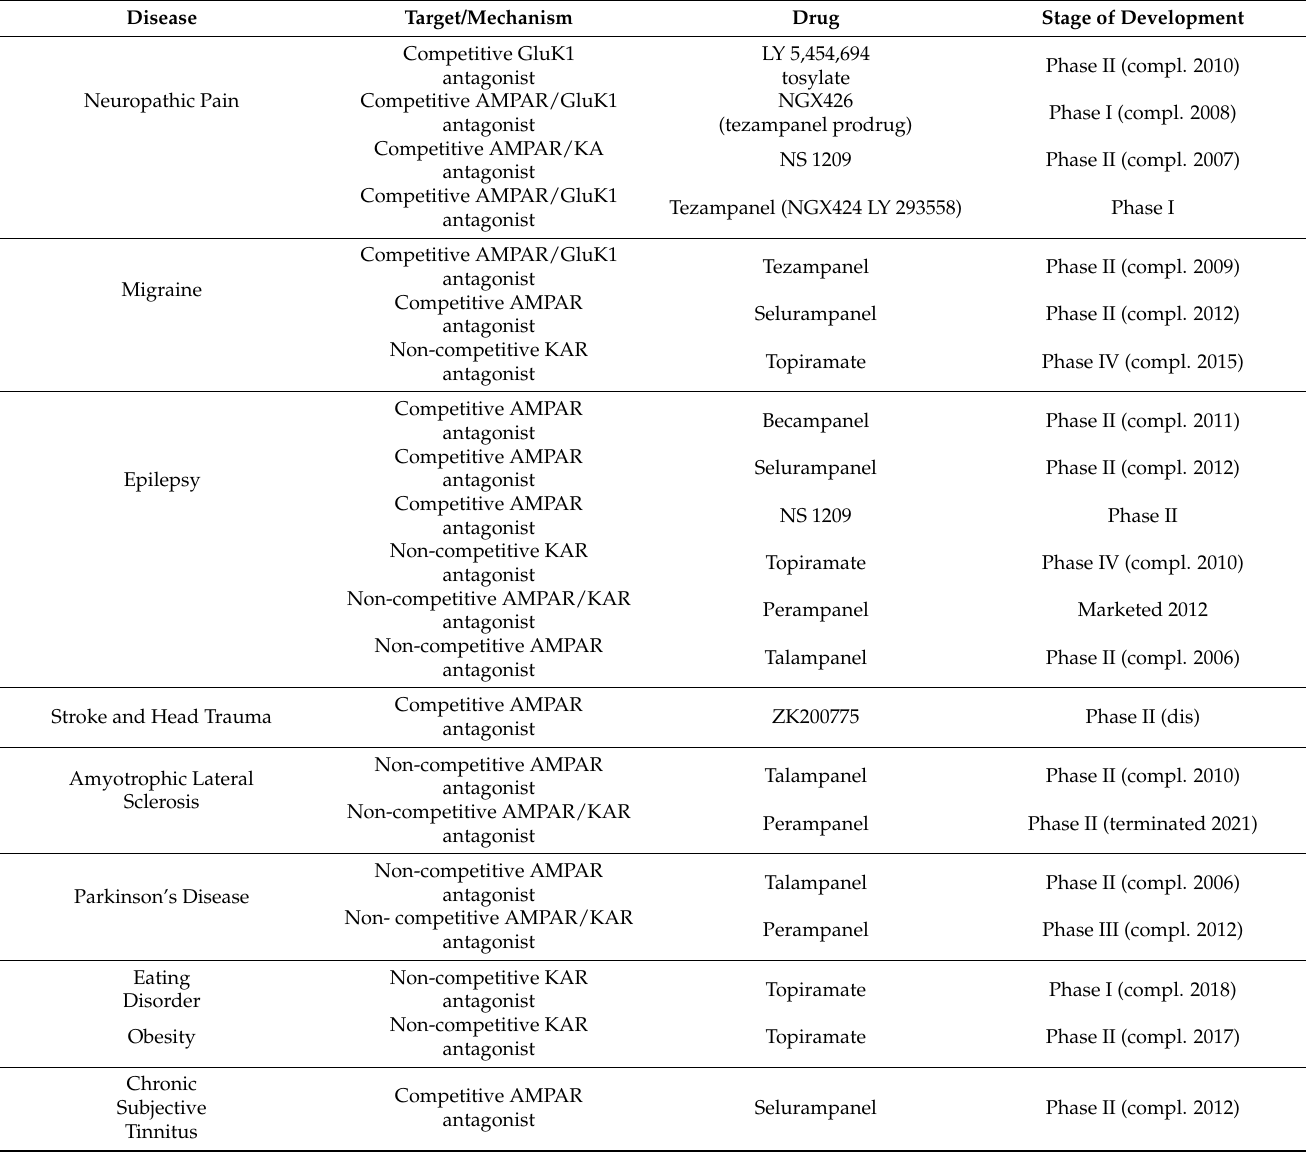
Table 10. Competitive and non-competitive AMPAR/KAR antagonists that have entered clinical trials in the last 15 years